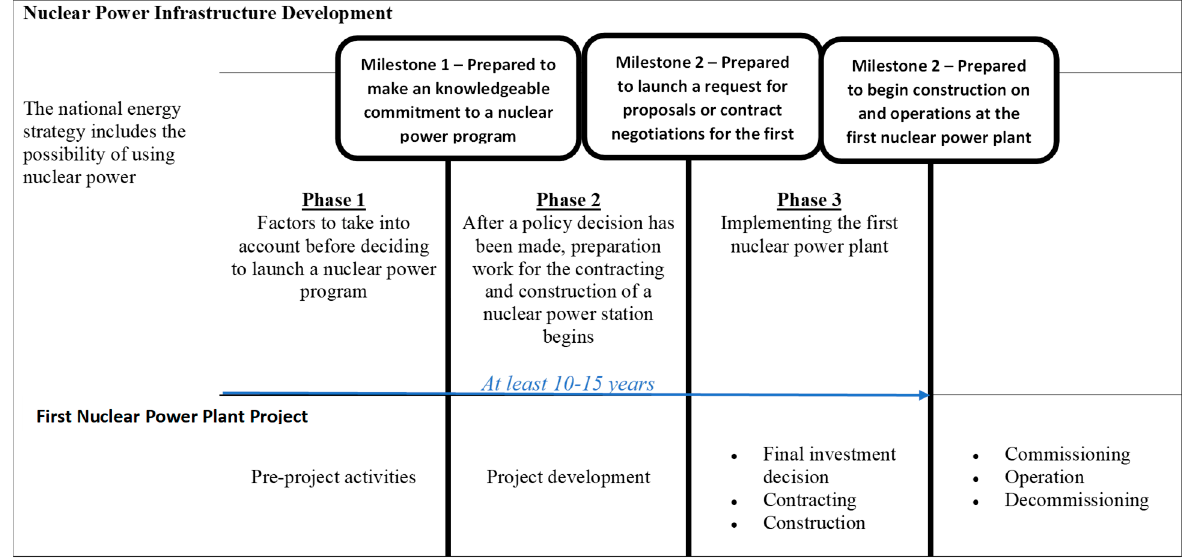
Figure 3. Developing infrastructure for a nuclear program: key milestones—Own elaboration based on data from [52].